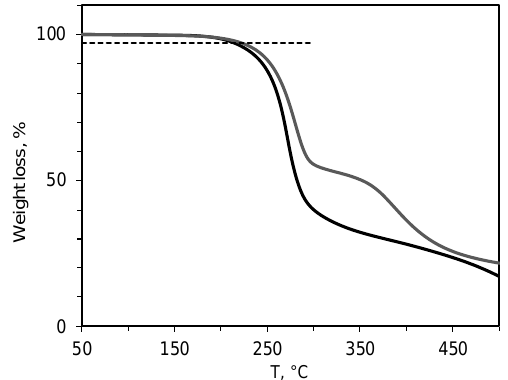
Figure 4. PTMSP with different contents of butylimidazole salt: 5 mol% (1) and 20 mol% (2). The dashed line represents the level of 3% of mass loss.